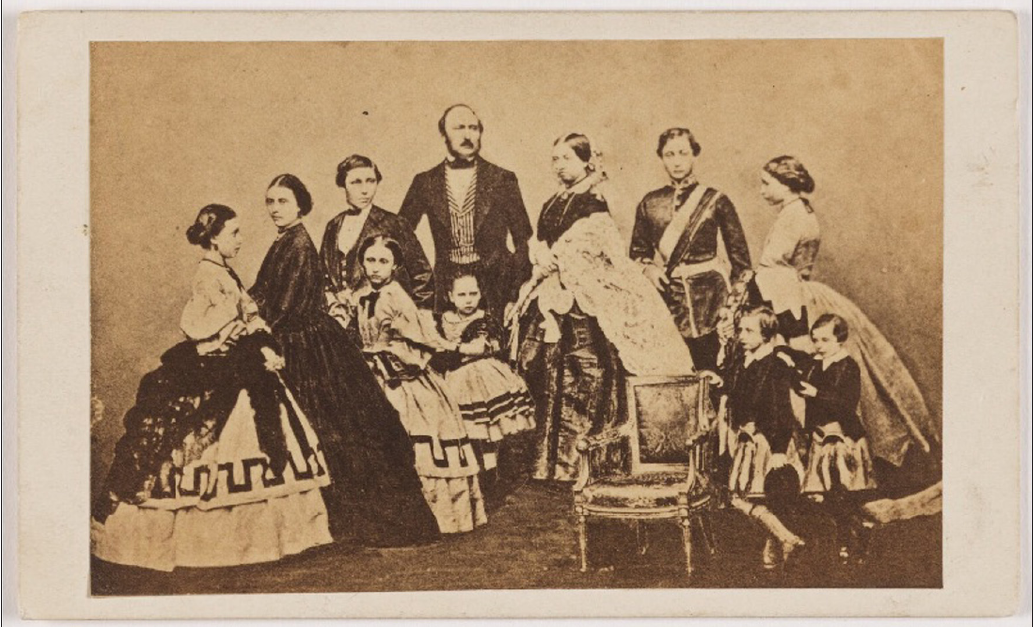
Fig. 1: After John Jabez Edwin Mayall, Queen Victoria with Her Family , 1860s, albumen carte de visite , 5.6 × 8.6 cm. © National Portrait Gallery, London. CC BY-NC-ND